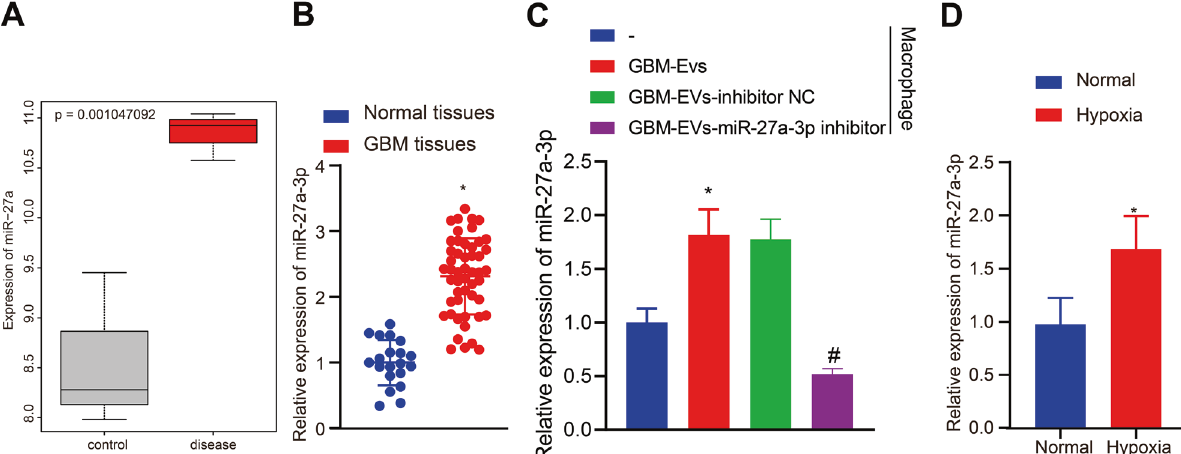
Fig. 2 hsa-miR-27a-3p is transferred into macrophages from GBM cells via EVs. A Differential expression of hsa-miR-27a-3p in microarray GSE65626. The X-axis represents sample type, and the Y-axis represents expression value. Gray box indicates normal samples ( n = 3), while red box indicates tumor samples ( n = 3). B RT-qPCR results of hsa-miR-27a-3p expression in clinical samples of patients with GBM ( n = 50) and non-GBM patients ( n = 20). C RT-qPCR results of hsa-miR-27a-3p expression in macrophages exposed to GBM-EVs relative to normal macrophages. D RT-qPCR results of hsa-miR-27a-3p expression in macrophages cultured under normoxia/hypoxia conditions following co- culture with GBM-EVs. * p < 0.05 compared with normal tissues, normal cells or macrophages treated with mimic-NC. # p < 0.05 compared with macrophages treated with GBM-EVs-inhibitor NC. The experiment was repeated 3 times